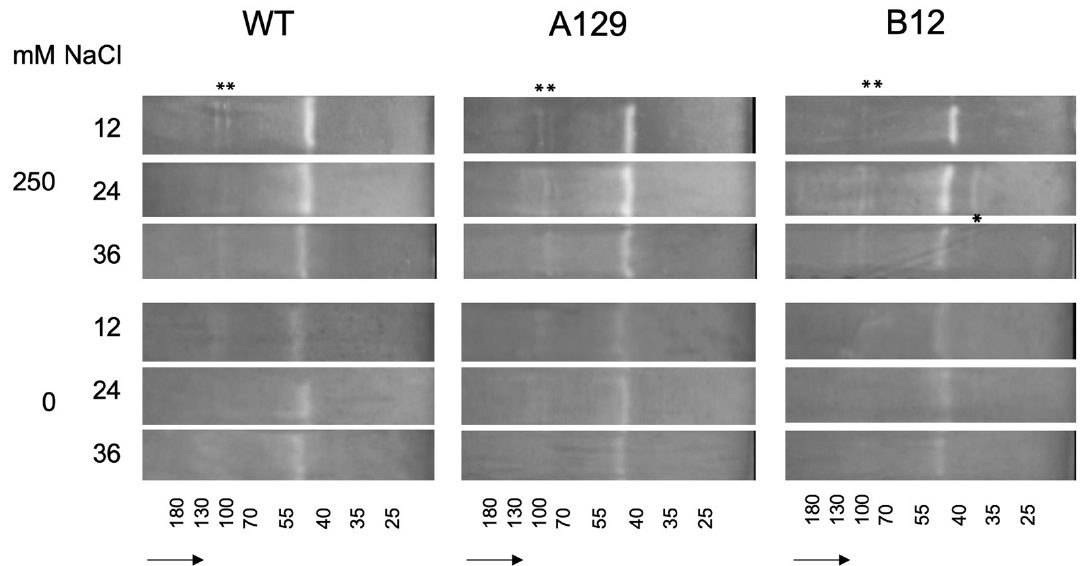
Figure 10. Superoxide dismutate (SOD) isoenzyme separation shown for two selected mutant lines in comparison to WT. Asterisks mark differences between WT and mutant control samples and 250 mM NaCl. For mutant line B12 an additional band is marked. The complete gels including the gel stained with Coomassie blue are shown in the Supplementary Materials (Figure S6). The small numbers at the bottom indicate the approximate molecular masses from marker mixtures. The arrows show the direction of sample flow.